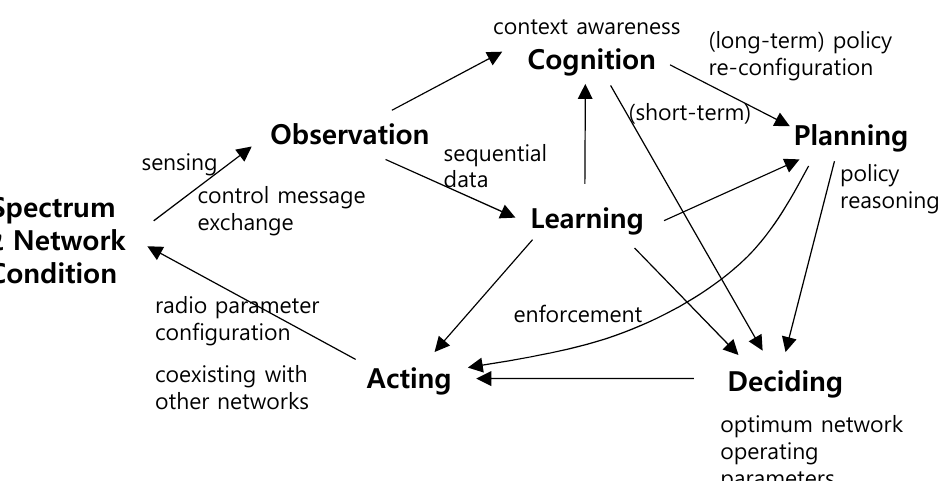
Figure 1. Intelligent cognitive radio ad-hoc network (CRAHN) functional cycle.